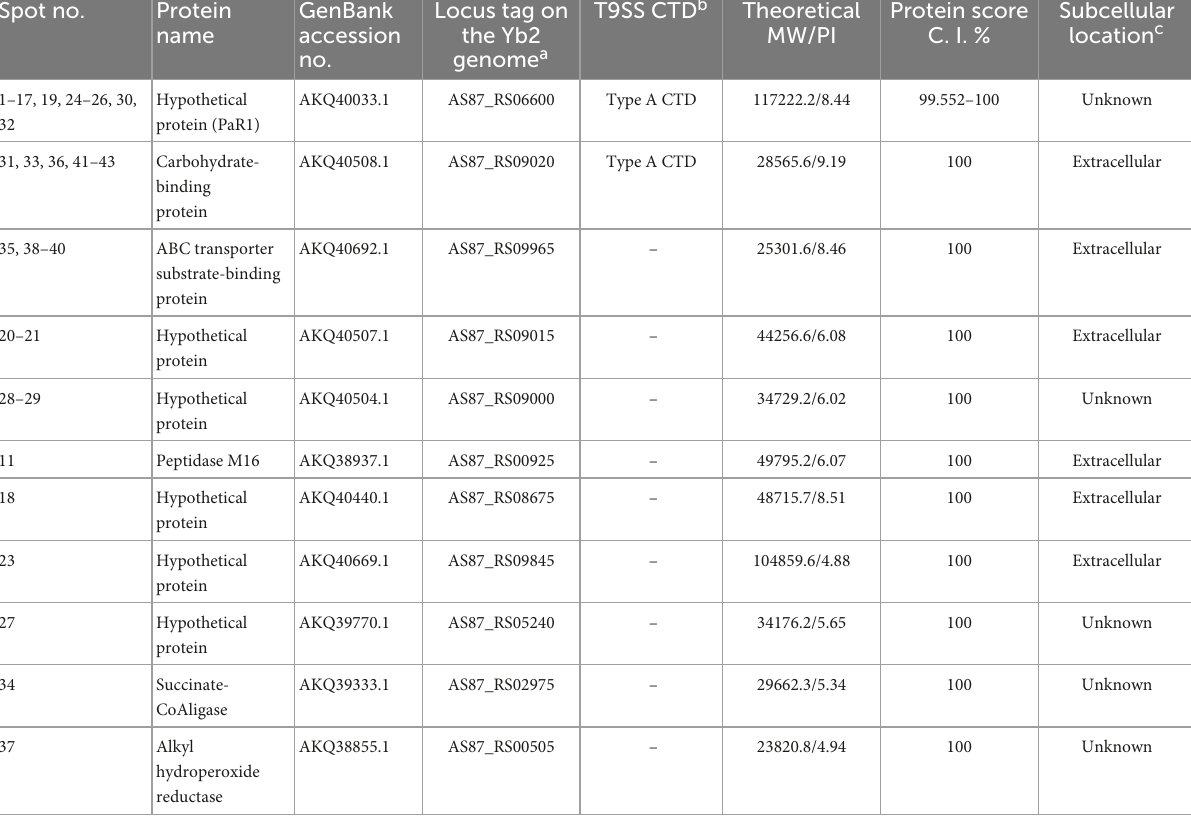
TABLE 2 Immunogenic proteins in the culture supernatant of Riemerella anatipestifer strain Yb2 identified by matrix-assisted laser desorption/ionization time of flight mass spectrometry (MALDI-TOF MS). Spot